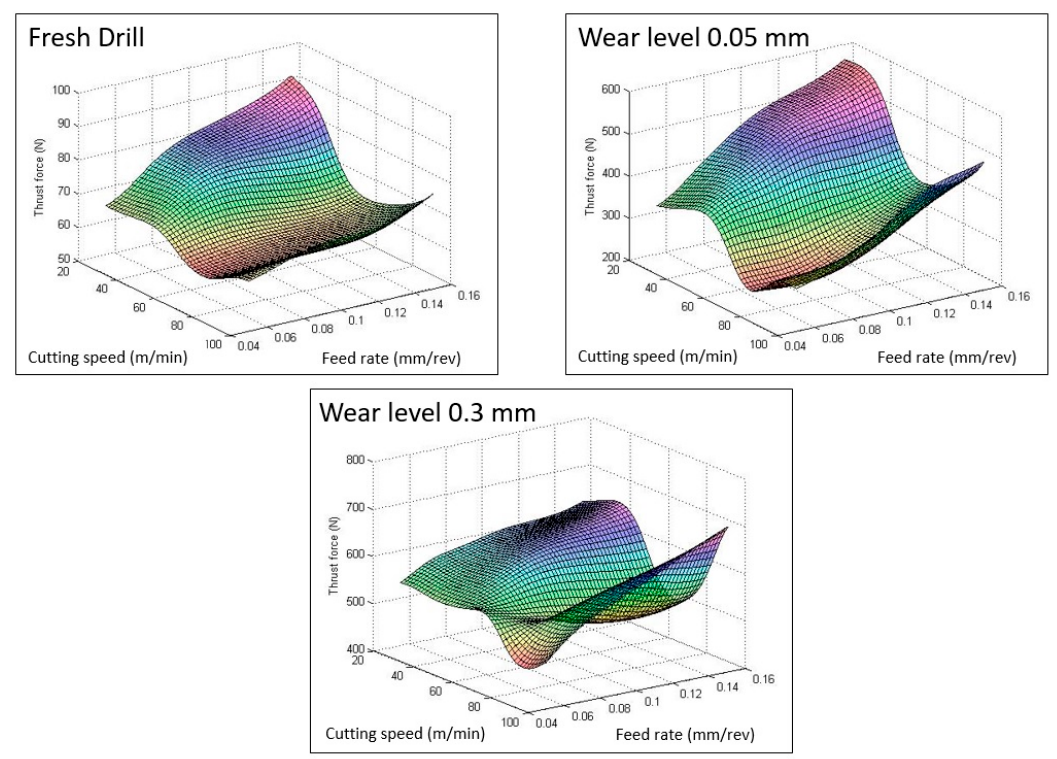
Figure 7. Variation of thrust force with cutting parameters for different wear levels (point angle = 118°).